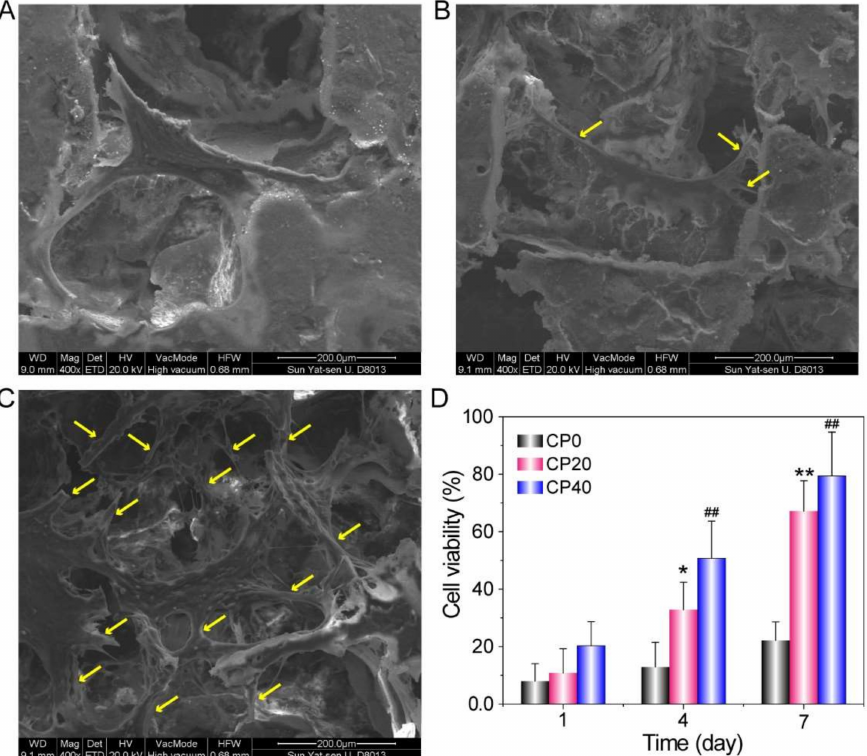
Figure 6. FESEM images of rBMSC cultured on CP0 ( A ), CP20 ( B ), and CP40 ( C ) at 24 h, and cell proliferation on the scaffold surfaces by the CCK-8 assay ( D ) (means ± SD, n = 5). The * p < 0.05 and ** p < 0.01 are the CP20 group vs. the CP0 group; ## p < 0.01 are the CP40 group vs. the CP0 group at the same time.